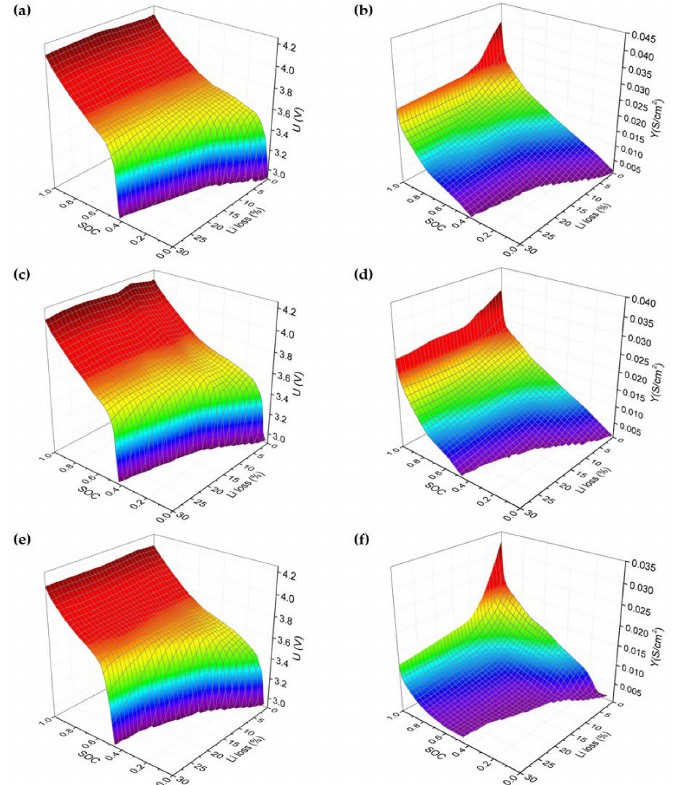
Figure 6. Three-dimensional graphs of U and Y with respect to SOC and cyclable lithium loss: ( a , b ) for cells 1, 4, and 7; ( c , d ) for cells 2, 5, and 8; and ( e , f ) for cells 3, 6, and 9.